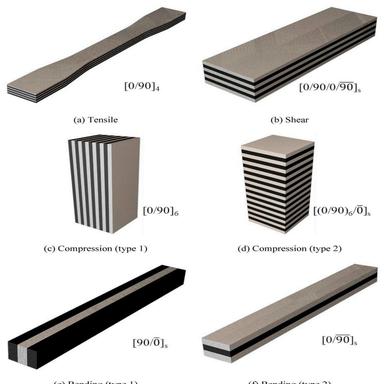
Compilation the of specimens for the FE simulation.